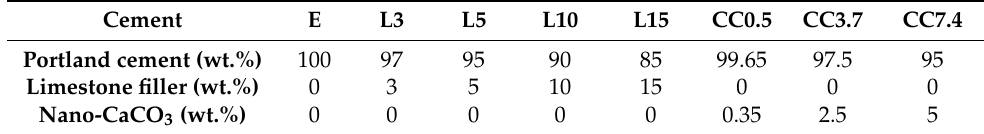
Table 2. Composition of the studied cements.